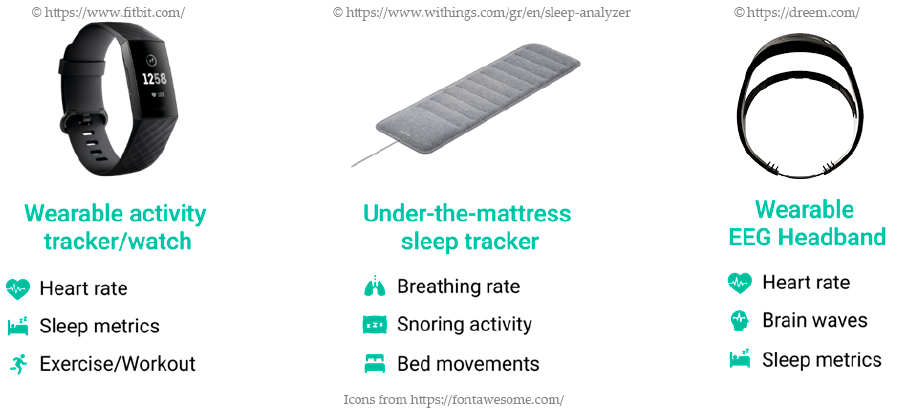
Figure 10. Sleep trackers utilized by